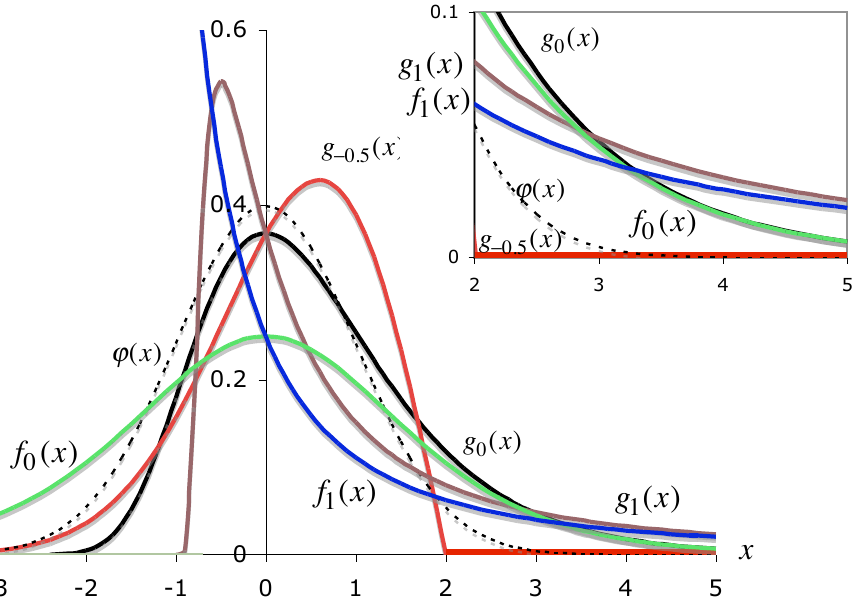
Figure 2. PDFs g ξ ( x ) = dG ξ ( x ) / dx , for ξ = − 0.5,0,1, together with the normal PDF, ϕ ( x ) = √ exp ( − x 2 /2 ) / 2 Φ , x ∈ R , and the GMS PDFs f ξ ( x ) = dF ξ ( x ) / dx , ξ = 0,1, with G ξ and F ξ given in (12) and (19),